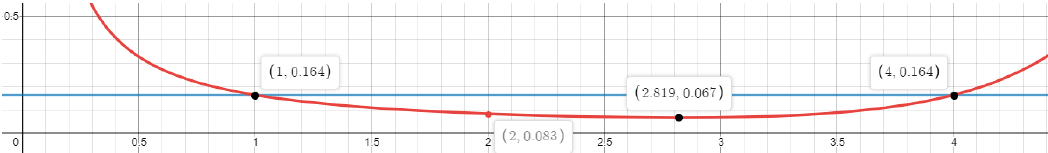
Figure 8. Delay bound of the proposed framework (the red curve) with p = 8, E = 4, F = 8 4 = 4096, r = 1 Gbps, L = 10 Kbit, with varying h. When h = 2, the delay bound is 0.083 s. When h = 1 and h = 4, it is 0.164 sec, which is identical to the delay bound given with IntServ. The delay bound of the ATS framework is 0.328 s. The red curve reaches the minimum with h = 2.819.